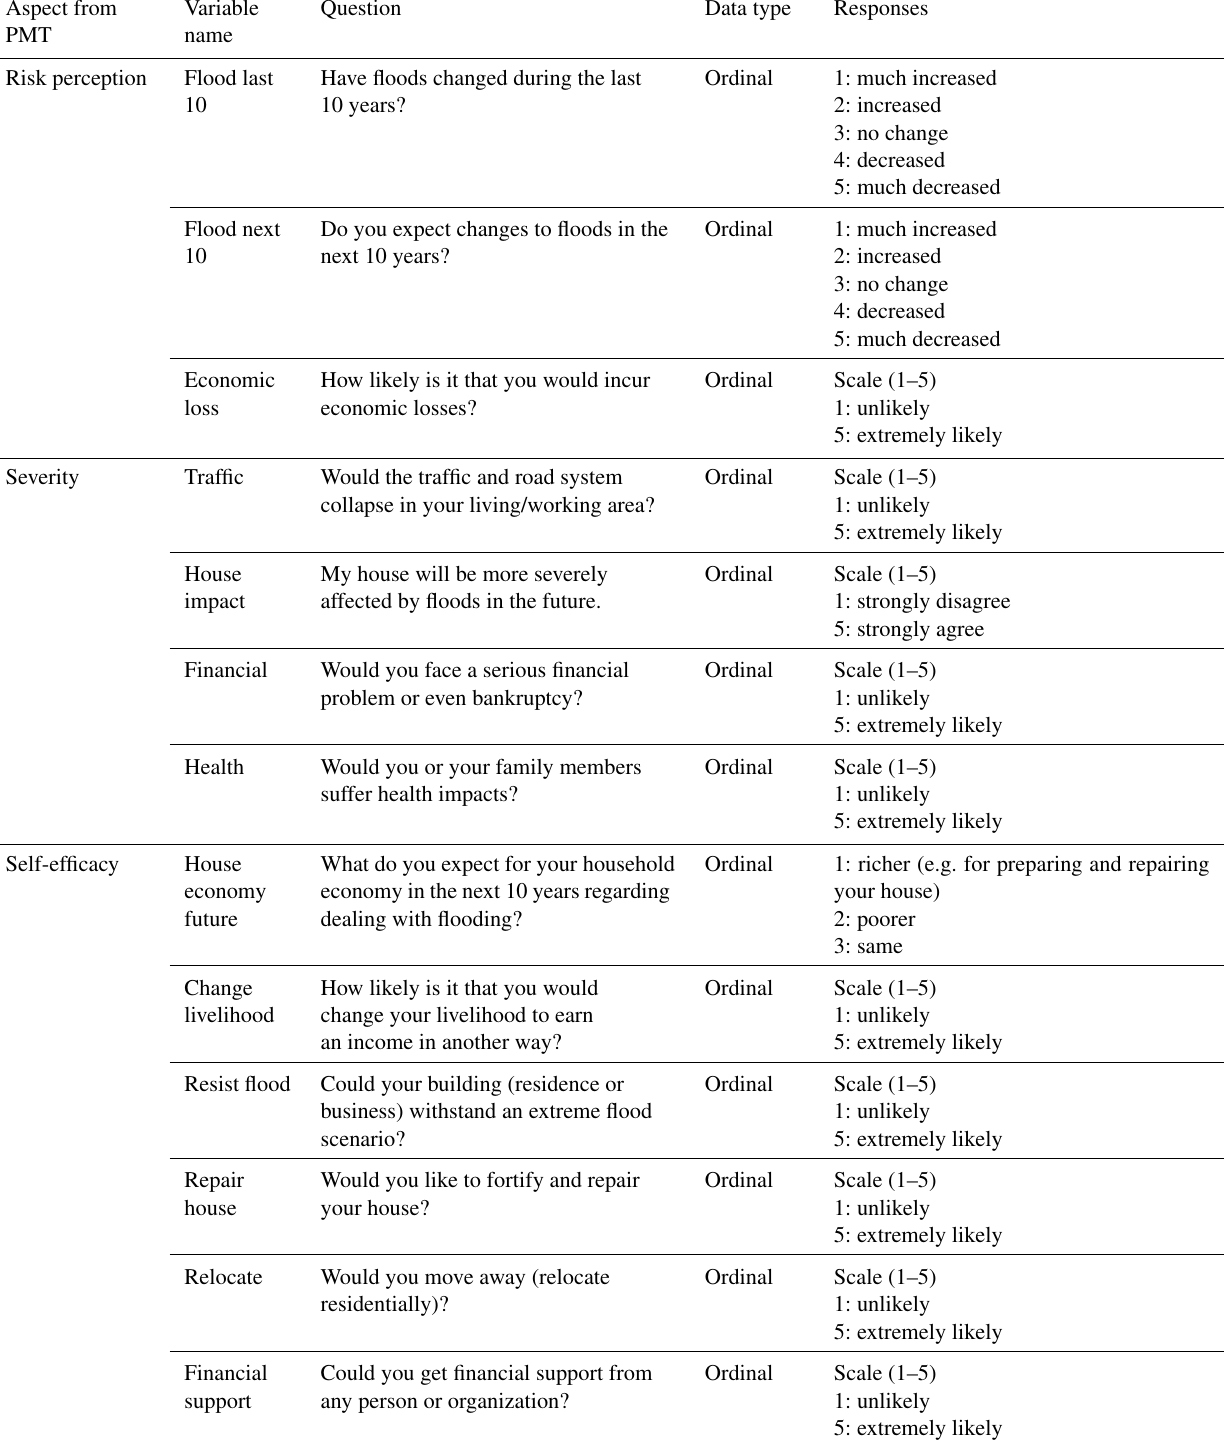
Table A1. This table presents the questions and their corresponding responses from the household survey corresponding to the protection motivation theory (PMT) framework (see Fig.